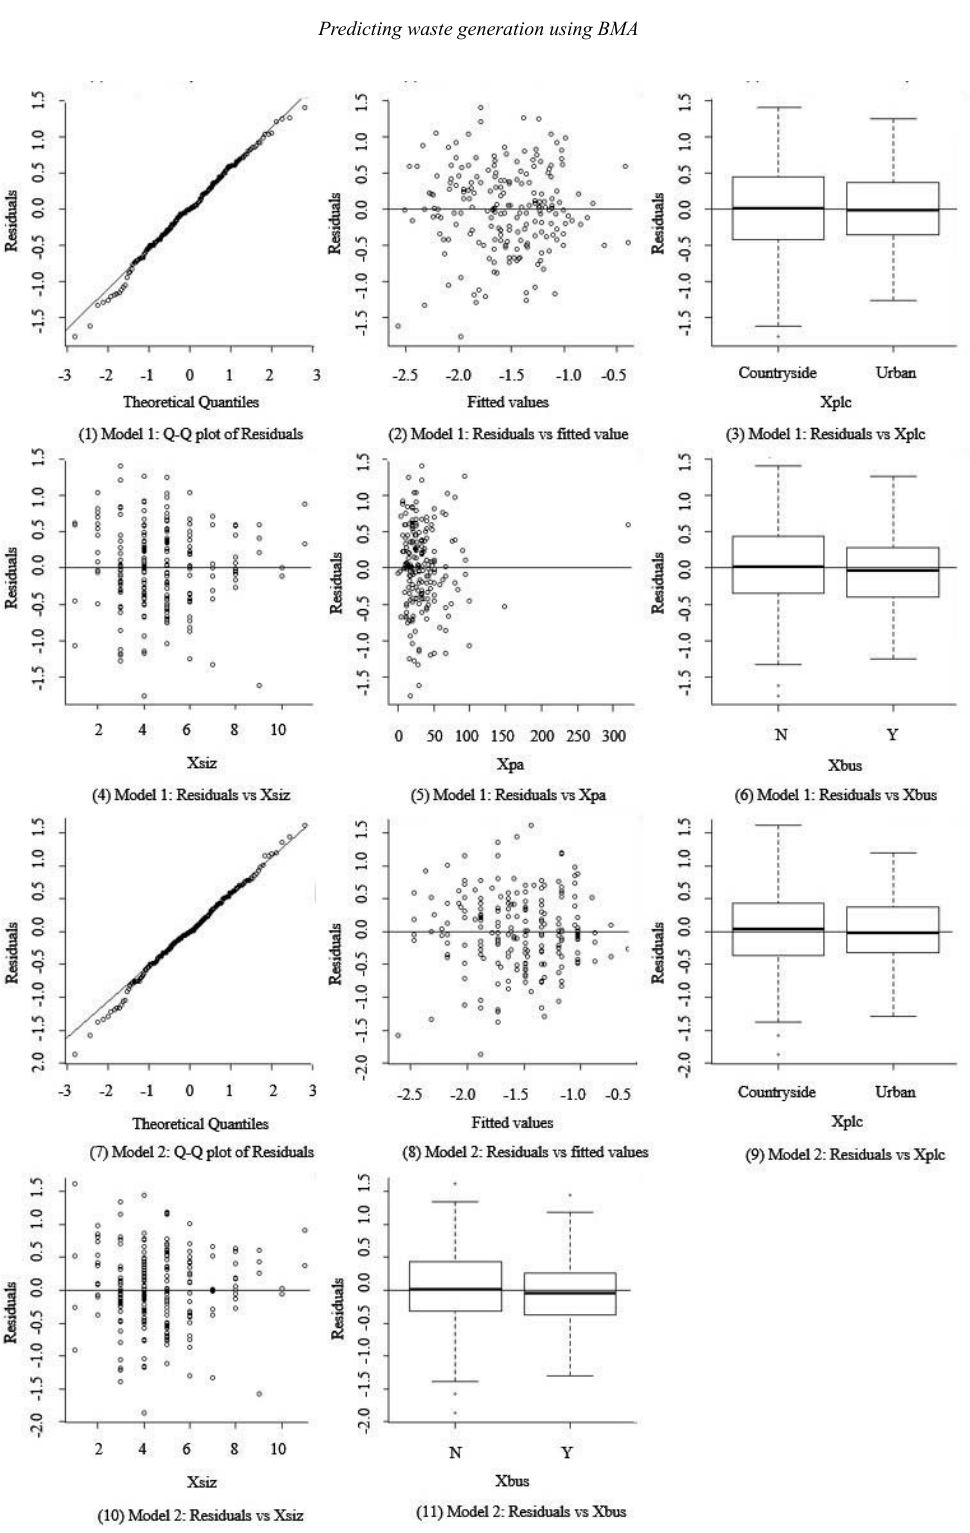
Fig. 6: Tests for the linear assumption of Models 1 and 2